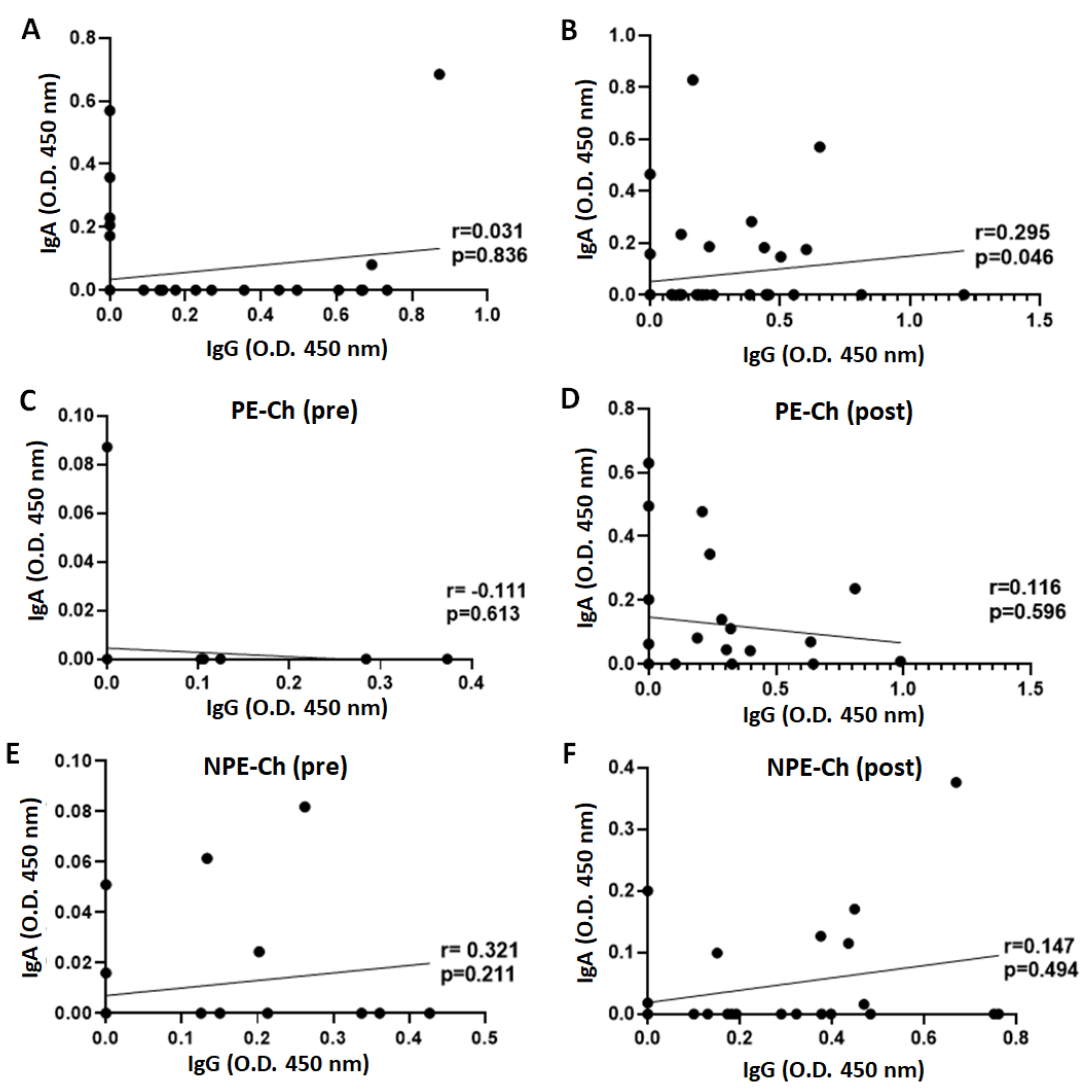
Figure 6. Spearman’s rank correlation coefficient analysis between serum levels of IgA and IgG in the volunteer groups before (pre, A , C , E ) and after 30 days of the administration of the second dose (post, B , D , F ) of CoronaVac (PE-Co, A , B ) or ChadOx-1 (PE-Ch— C , D ; NPE-Ch— E , F ) vaccines.